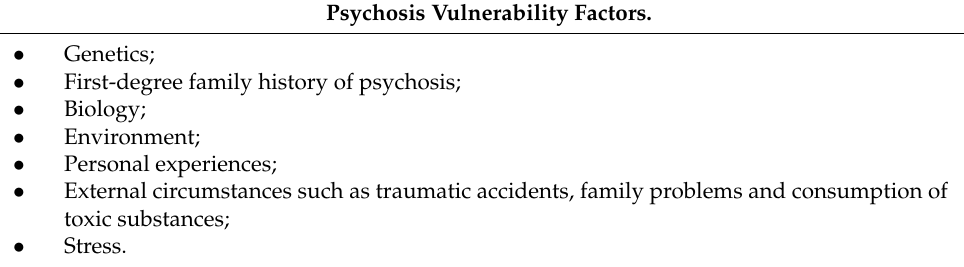
Table 2. Vulnerability factors for the appearance of